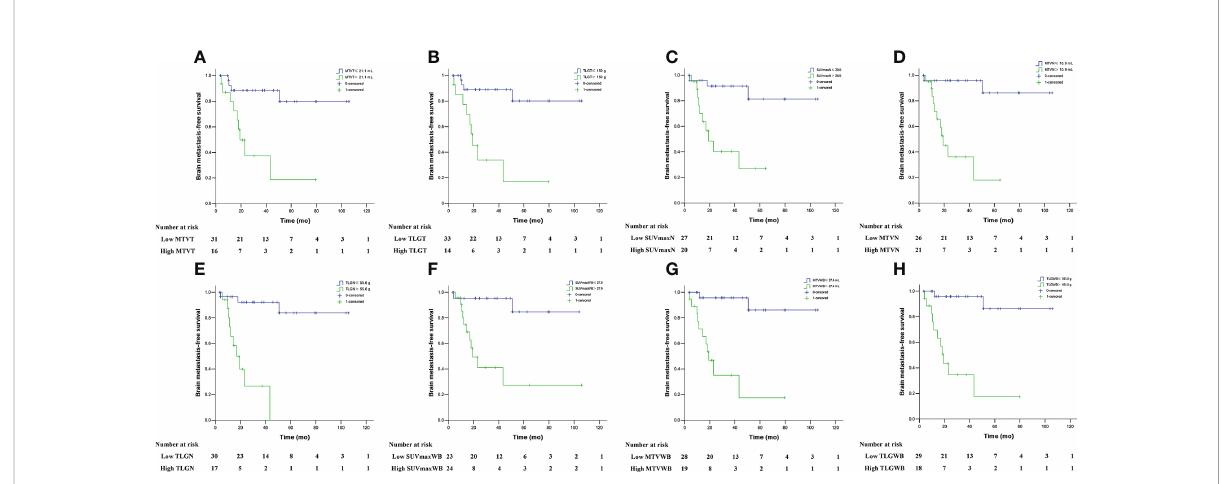
FIGURE 2 Brain metastasis-free survival in locally advanced NSCLC patients strati fi ed by MTV T (A) , TLG T (B) , SUV maxN (C) , MTV N (D) , TLG N (E) , SUV maxWB (F) , MTV WB (G) , and TLG WB (H)